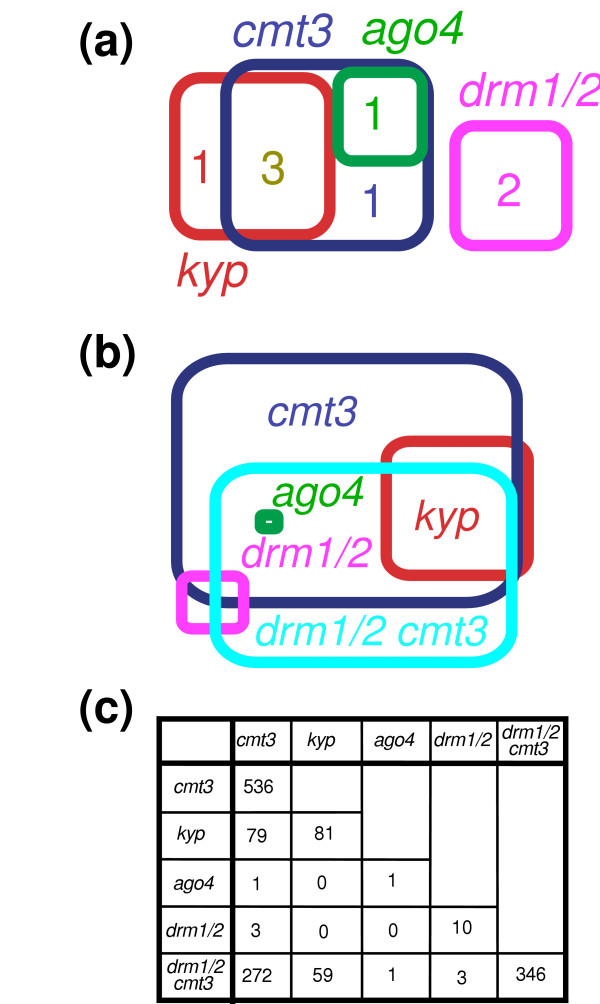
CNG methylation targets of epigenetic silencing components. (a) Venn diagram summaries of positive loci using random-PCR arrays in cmt3, kyp, drm1/2 and ago4 mutant backgrounds. Loci were scored as positive if methylation was significantly changed in the indicated mutant relative to the Ler wild-type background. (b) Venn diagram summaries of positive loci using gene-oligo arrays, where cmt3, kyp, drm1/2 and ago4 were in a Ler (clk-st) and crm3 drm1/2 was in a Ws wild-type background. Gene-oligo and random-PCR datasets of targets are available with a graphical interface for browsing and for downloading [25]. (c) Table showing the number of positives and overlaps for each mutant class. Mutants are color coded for clarity in the Venn diagrams.